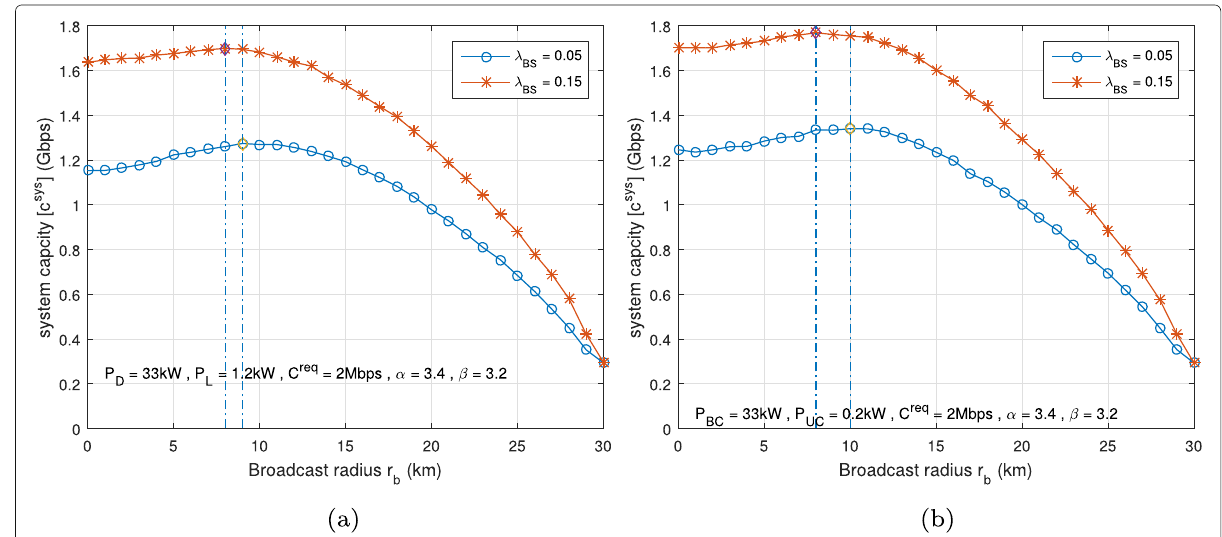
Fig. 8 Average system capacity vs. the BC radius r b for − 105 dBm noise power, C req of 2 Mbps, and 1400 users. a Shared spectrum